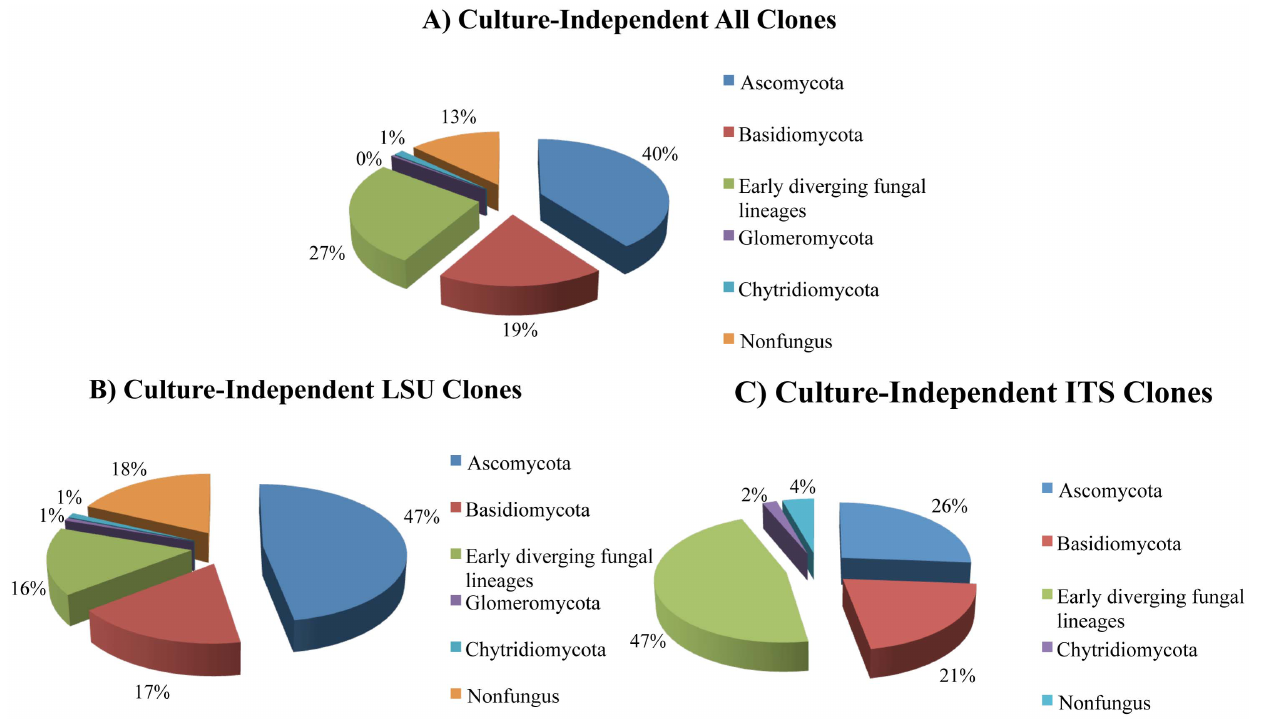
Figure 3. Phyla distribution in culture-independent (CI) clones. A) Relative proportions of different phyla of all clones; B) Relative proportions of different phyla of LSU clones; C) Relative proportions of different phyla of ITS clones. The zero percent assigned in pie chart represents clones with less than 1% relative distribution.